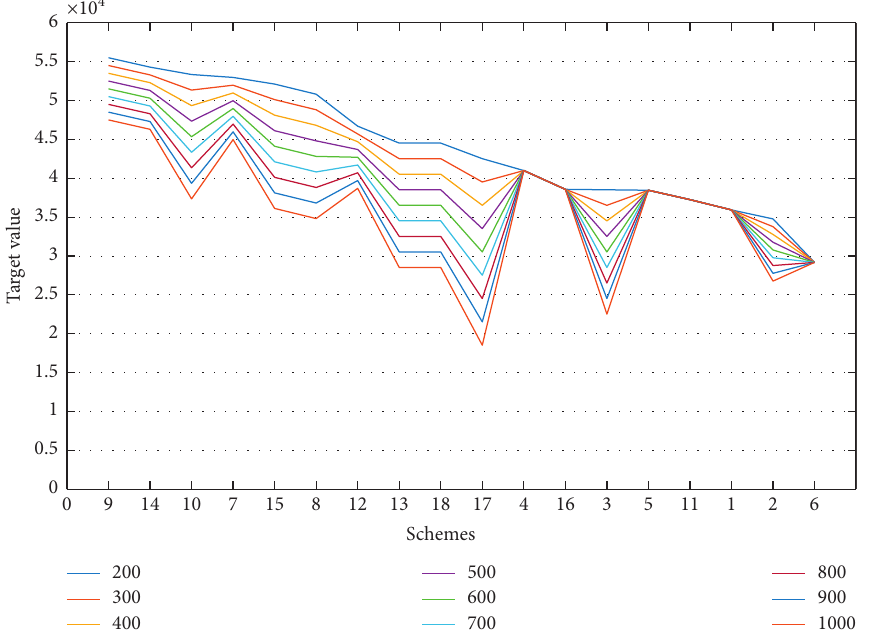
Figure 8: C � 1: target values of various schemes under different adjustment cost coefficients of existing railway z